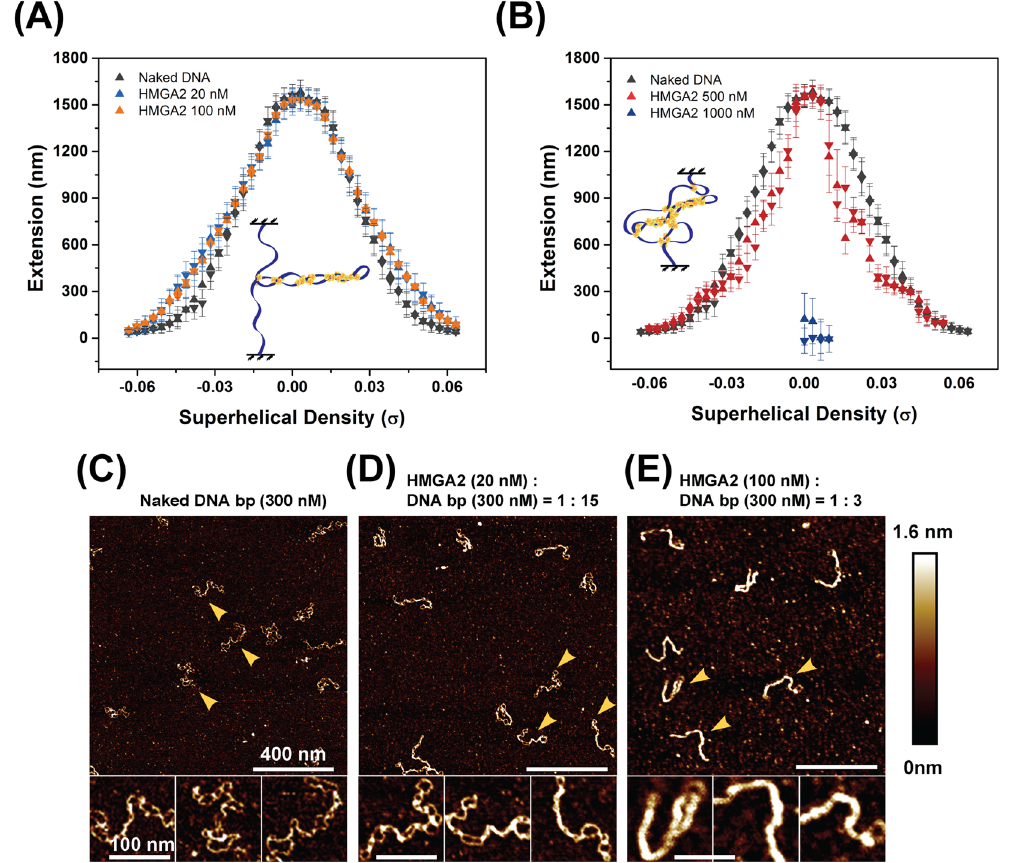
Figure 3. Binding of HMGA2 to sc DNA. ( A , B ) Representative Lk -extension curves of a torsionally constrained DNA at 0.3 pN in different HMGA2 concentrations. Data obtained in a forward process with increasing DNA winding ( + σ ) or unwinding ( − σ ) are indicated by up-triangles, and those in a reverse process are indicated by down-triangles. The insets depict models of HMGA2-sc DNA complexes; see text for details. ( D , E ) AFM images of 2686 bp negatively supercoiled DNA bound with HMGA2 with different HMGA2: DNA base pair stoichiometric ratios. Images obtained on naked supercoiled DNA ( C ) are shown for comparison. In each panel in ( C – E ), three representative DNA molecules indicated by the arrows are enlarged three-fold for better visualization of the conformations of the supercoiled DNA molecules. The panel titles in ( C – E ) indicates the molar concentrations of HMGA2 and DNA basepairs as well as their